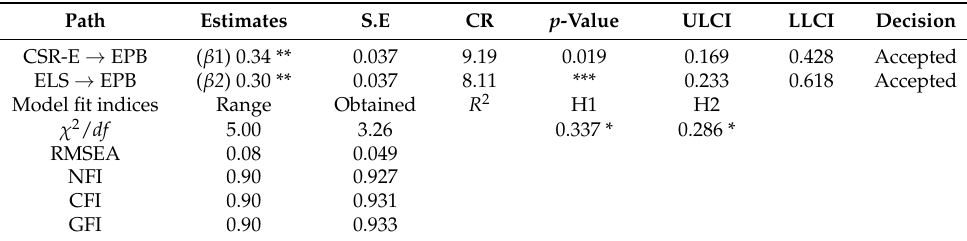
Table 4. The results for hypotheses 1 and 2. Path